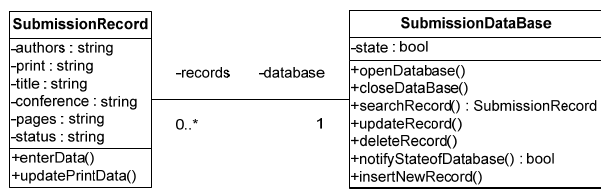
Fig. 6. Classes obtained from the TFM of the system “to be”. Class Diagram : The classes SubmissionRecord and SubmissionDataBase (Fig. 6) are obtained by transforming those functional features of the TFM of the system “to be”, which have trace links to FR1, into types of the objects O . The traceability matrix from these classes (table rows) to the functional features of the TFM of the system “to be” (table columns) is given in Table III.